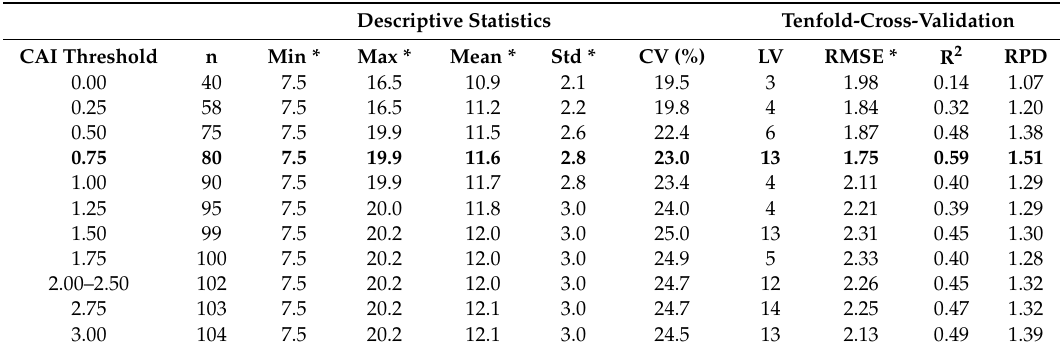
Table 3. Descriptive statistics of the SOC calibration dataset and the results of the Partial Least Squares Regression (PLSR) model applying the Cellulose Absorption Index (CAI) thresholds. In bold is the best model. CV = variation coe ffi cient, LV = latent variables.